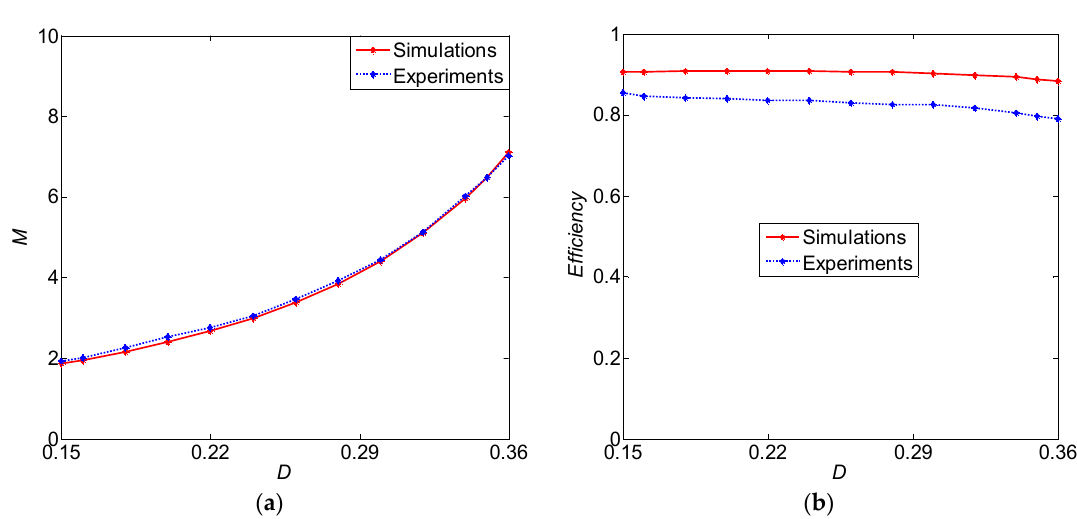
Figure 6. The Saber simulations and the experiments about the voltage conversion ratio M and the efficiency for the proposed step-up converter under case 1. ( a ) The voltage conversion ratio M ; ( b ) The efficiency.